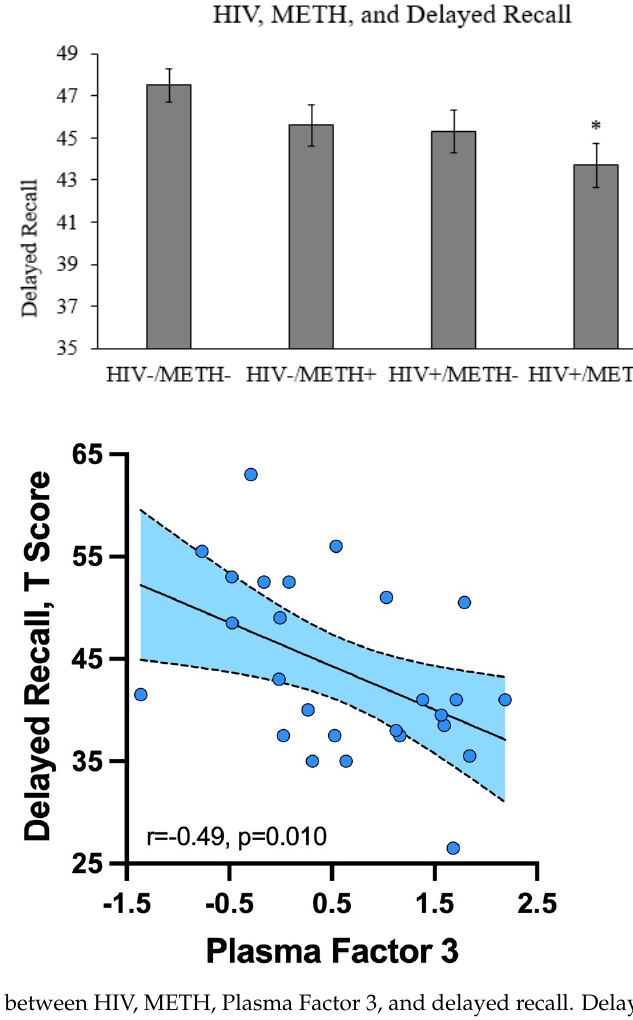
Figure 2. The relationship between HIV, METH, Plasma Factor 3, and delayed recall. Delayed recall was measured in each of the four groups. * = p < 0.05 compared to the HIV-/METH- group. Delayed recall negatively correlated with Plasma Factor 3 in the HIV+/METH+ group, but not any of the other three